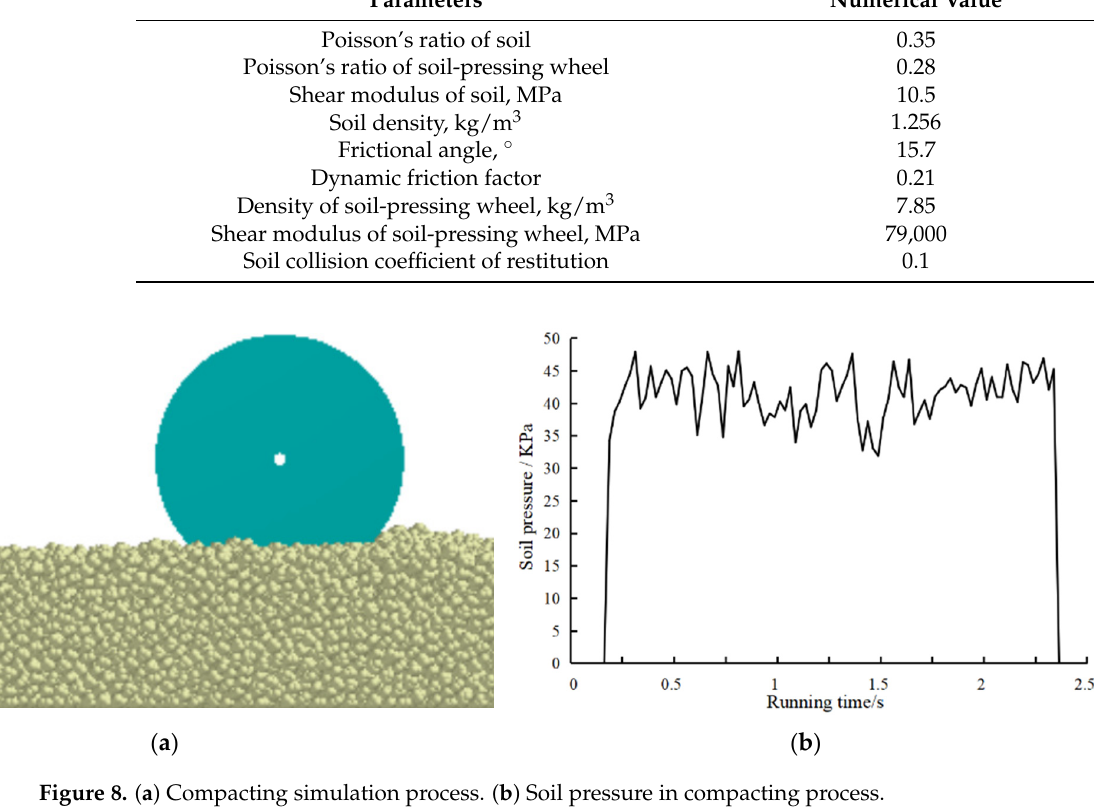
Figure 8. ( a ) Compacting simulation process. ( b ) Soil pressure in compacting process.